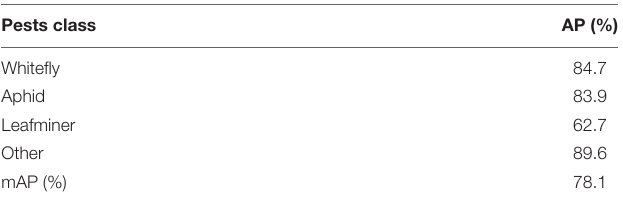
TABLE 5 | Algorithmic performance on practical images of healthy and unhealthy objects.